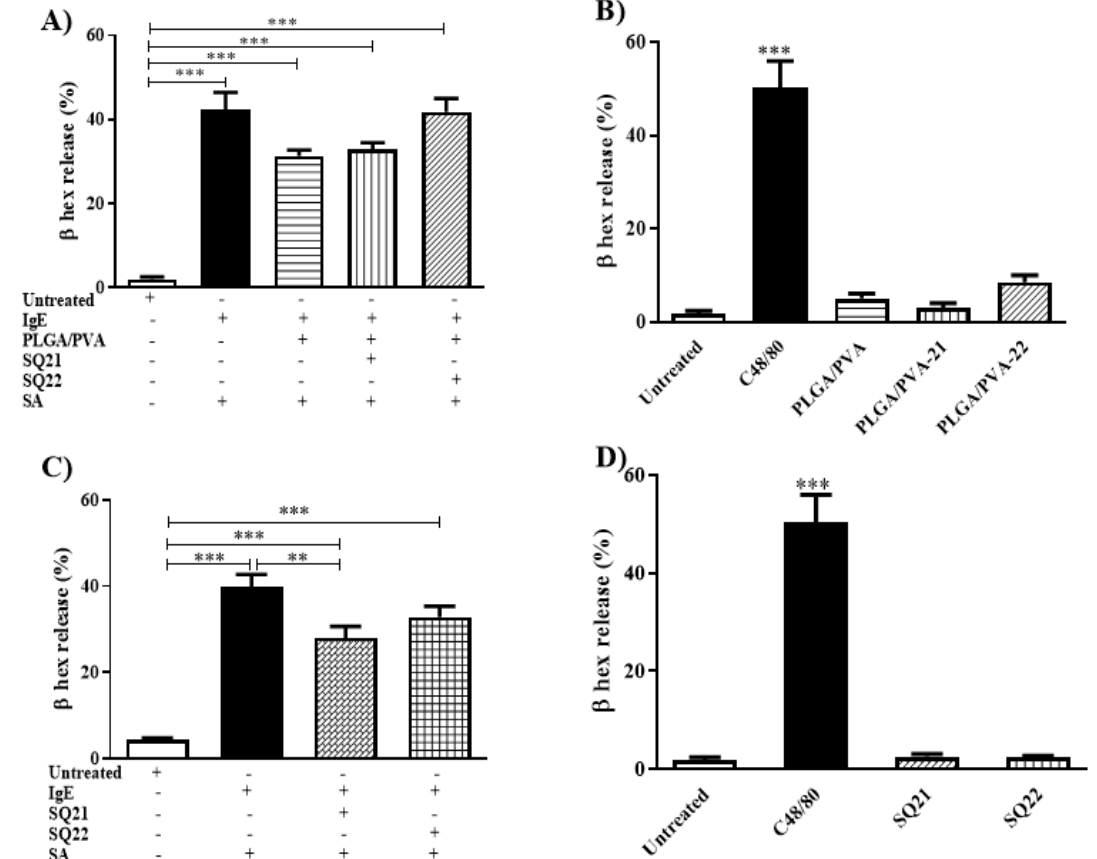
Figure 6. Inflammation mediator released by LAD2 cells treated with encapsulated SQs. LAD2 cells were sensitized overnight with biotinylated IgE, exposed to PLGA/PVA-21 or PLGA/PVA-22 ( A ), or SQ21, SQ22 ( C ) for 3 h and challenged with streptavidin for 30 min, and β -hexosaminidase release was evaluated in LAD2 cells. Untreated cells or IgE-SA sensitized and challenged cells were included as negative and positive controls, respectively. PLGA/PVA-21 or PLGA/PVA-22 ( B ), or SQ21 and SQ22 ( D ) cell activation was measured after 30 min incubation. Untreated and compound 48/80 treated cells were included as negative and positive controls, respectively ( n = 3 ± SEM; ** p ≤ 0.01, *** p ≤ 0.001).